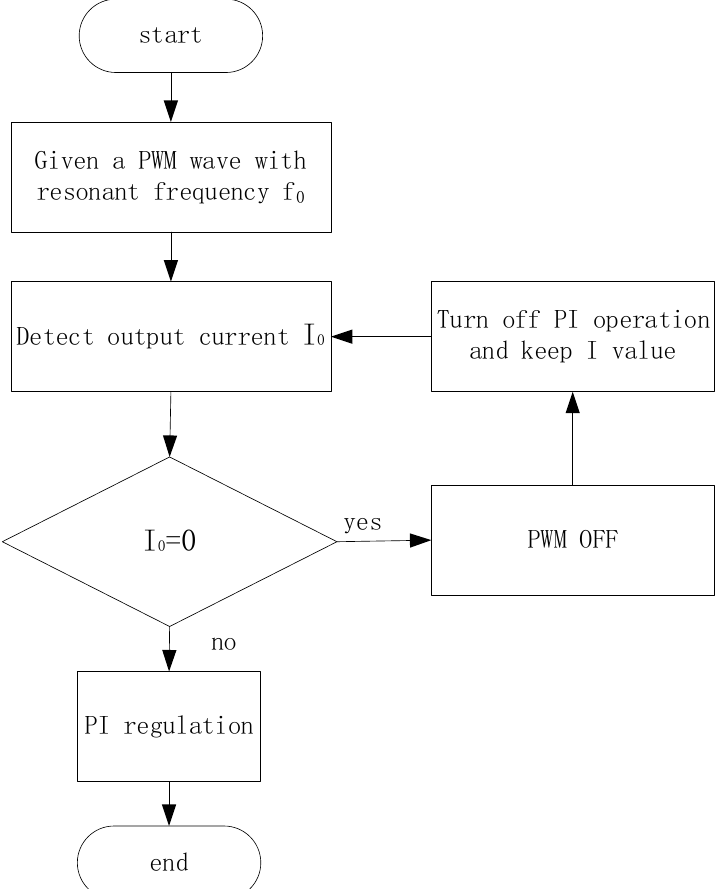
Figure 5. Flow chart of intelligent PI closed-loop control strategy. Figure 6 is the waveform diagram of pulse current intelligent PI closed-loop control under digital closed-loop simulation. The first waveform is the voltage and current wave- form of the LLC resonant cavity. There is no voltage and current in the resonant cavity during the pulse off period, indicating that the PWM is turned off; the second waveform is the output pulse current waveform. Load interference is added at 0.041s in the model. It can be seen that the output current returns to the set 20 A within 10 ms, which is very stable without a pulse spike; the third waveform is the count value corresponding to the drive frequency.